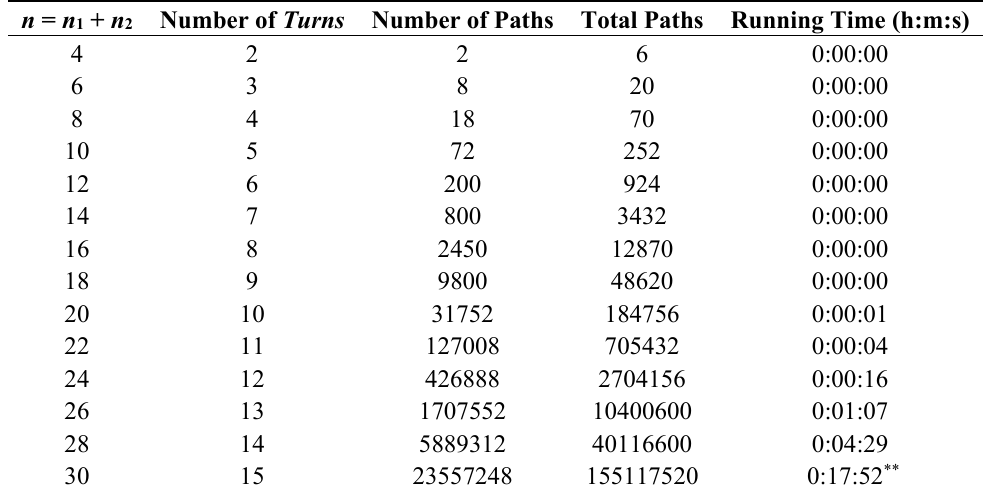
Table 5. Running Time of Permute +